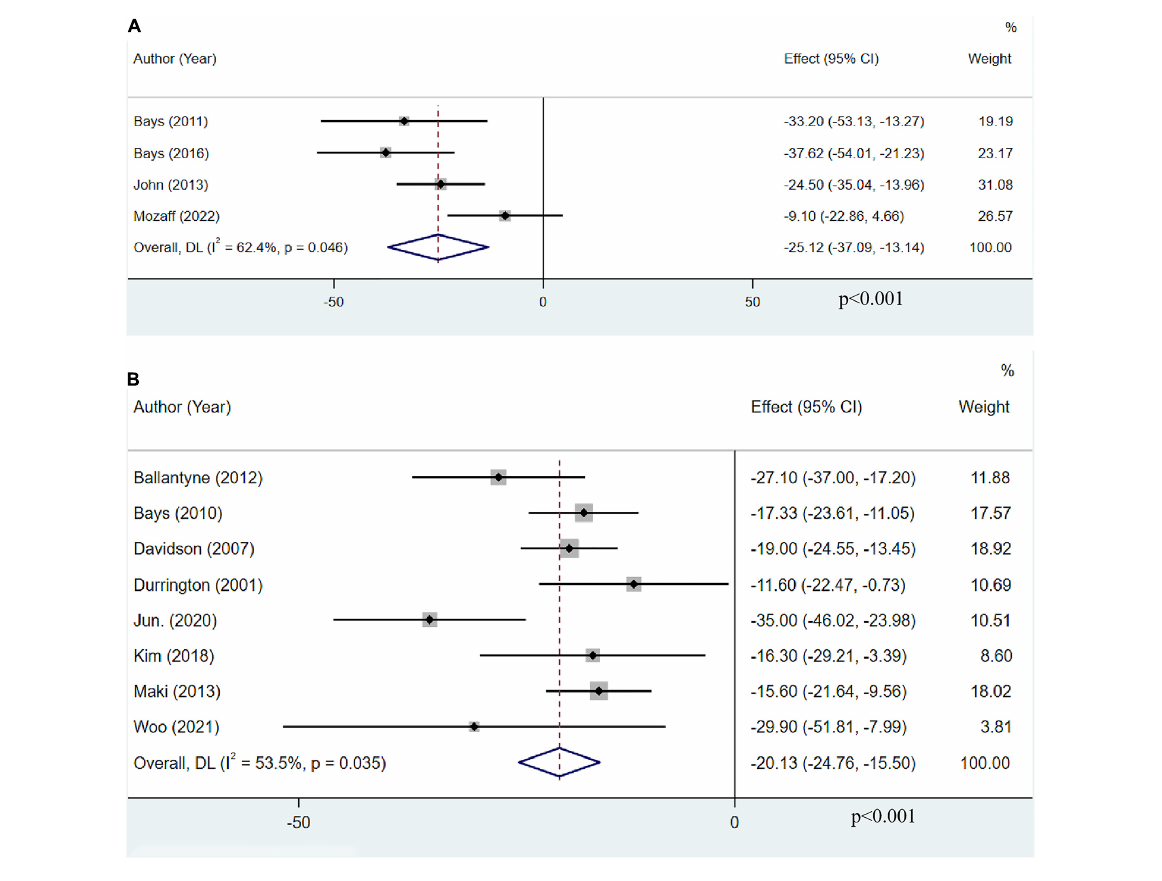
FIGURE7 The effect of OM3-FA on VLDL-C. (A) OM3-FA monotherapy; (B) Combined therapy of statins plus